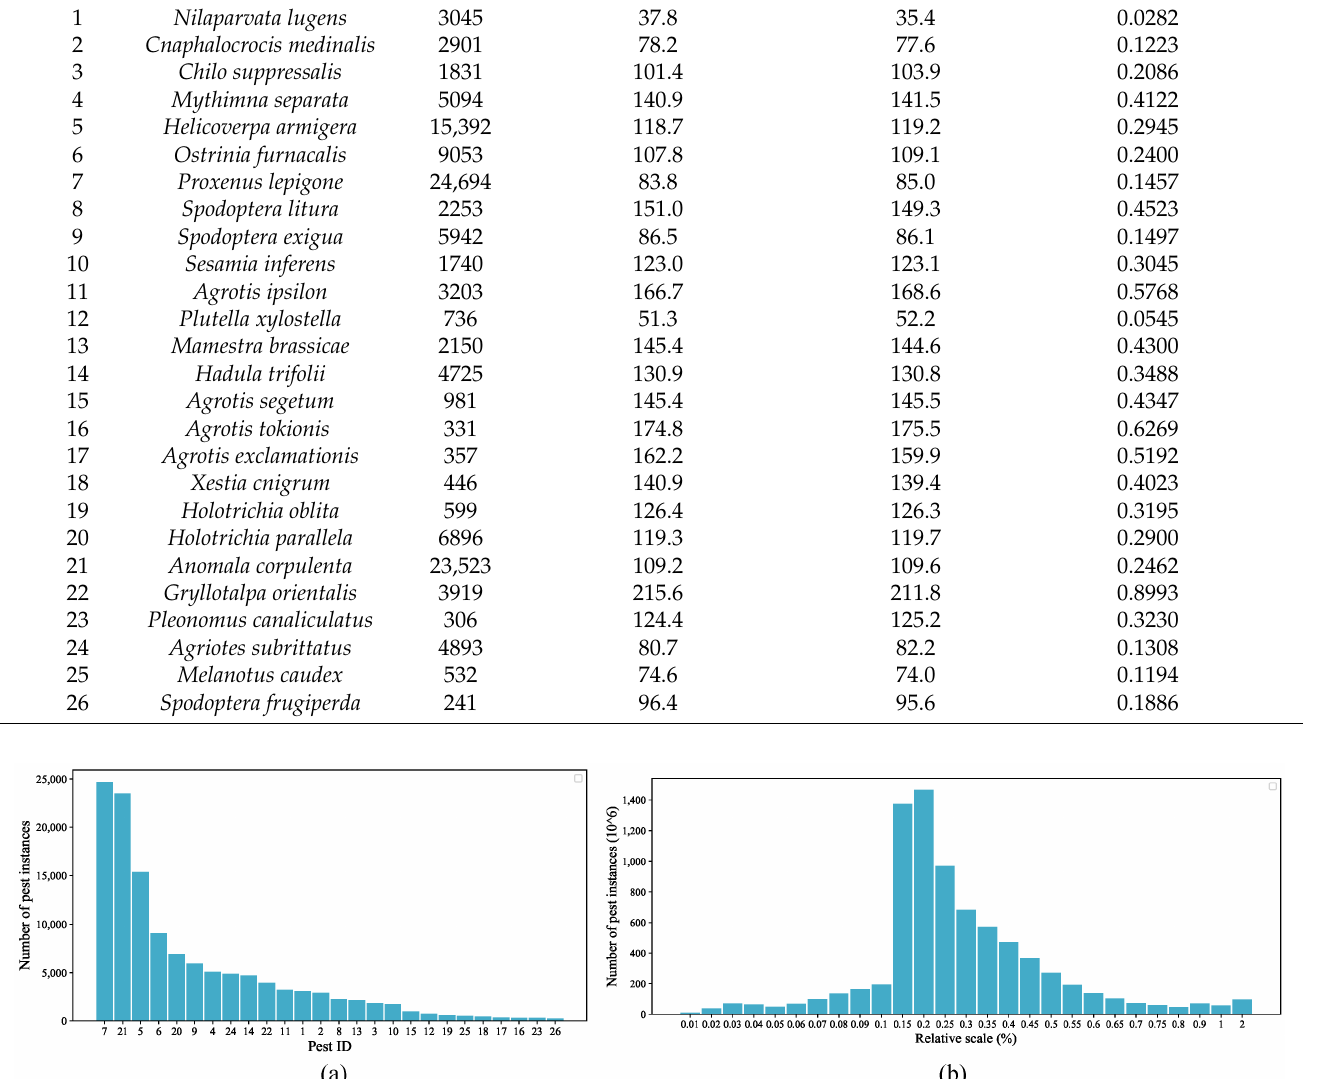
Figure 3. ( a ) Distribution of the number of pest specimens. ( b ) Relative scale distribution of the MPD2021 dataset